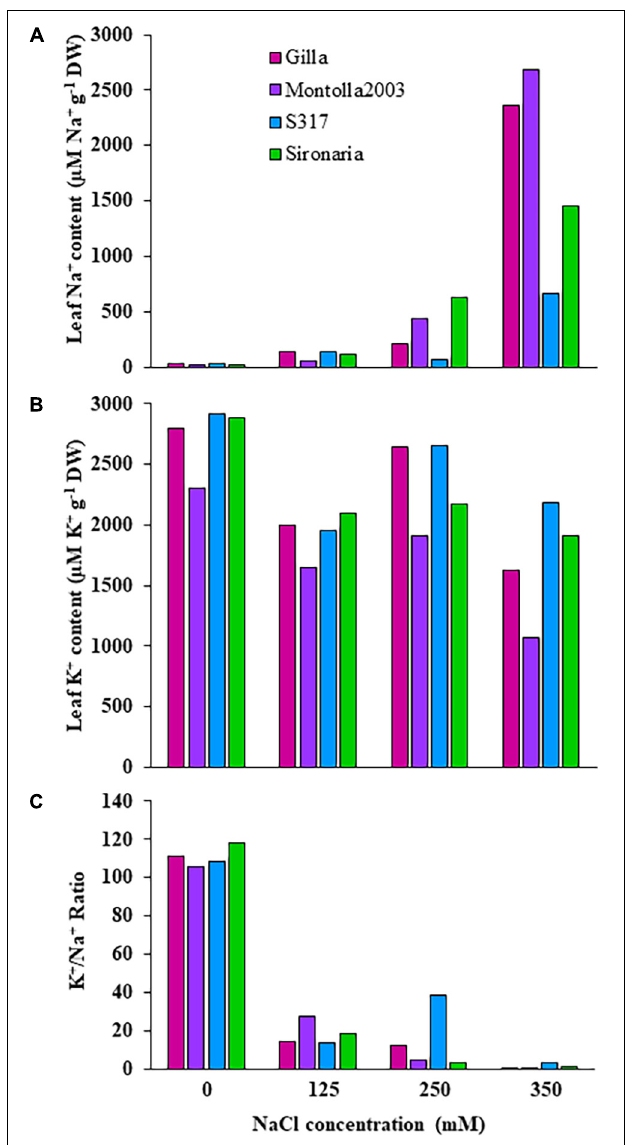
FIGURE 3 | Ion contents in third and fourth leaves of four safflower genotypes under four salt (NaCl) treatments from first experiment. (A) Sodium content, (B) potassium content, and (C) K + /Na + ratio in third and fourth leaves of four safflower genotypes at 36 days after